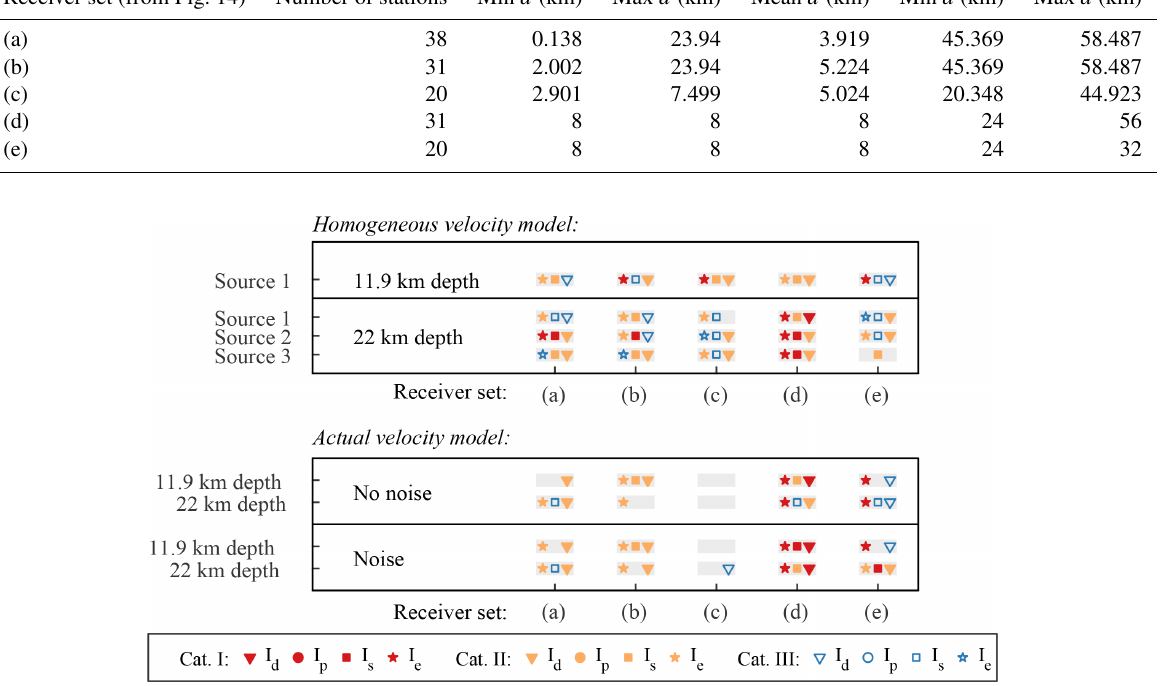
Table 2. Inter-station distances ( d ) and apertures ( a ) of the five receiver sets shown in Fig. 14. Receiver set (from Fig. 14)